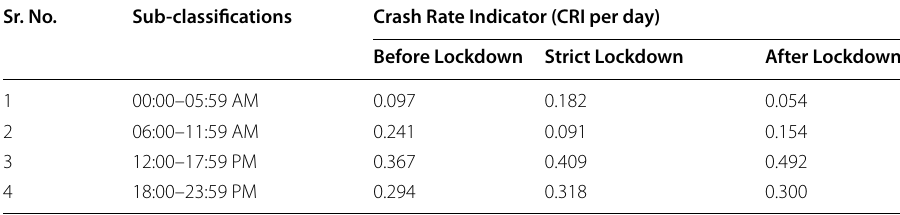
Table 10 CRI by time-wise analysis Sr. No.